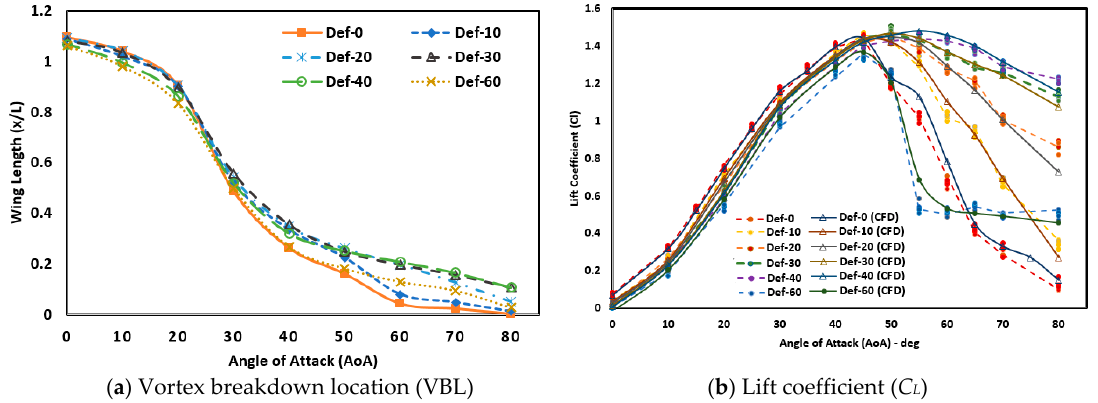
Figure 6. Vortex breakdown location, lift coefficient from water tunnel, and CFD results for various canard deflection angles δ .